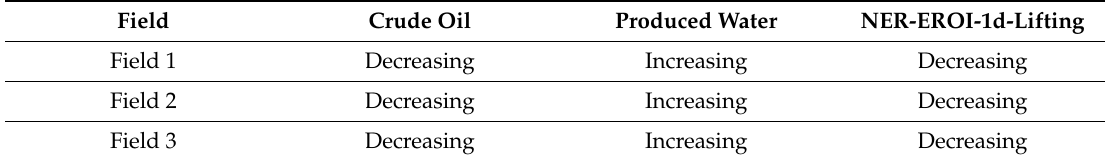
Table 5. Trends for three small fields.